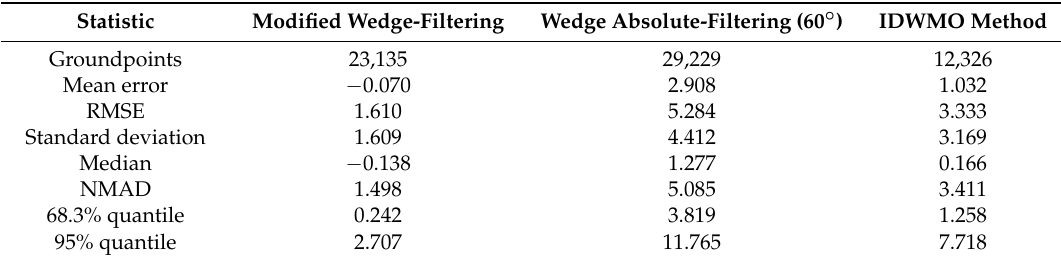
Table 1. Statistical values for the first test area.